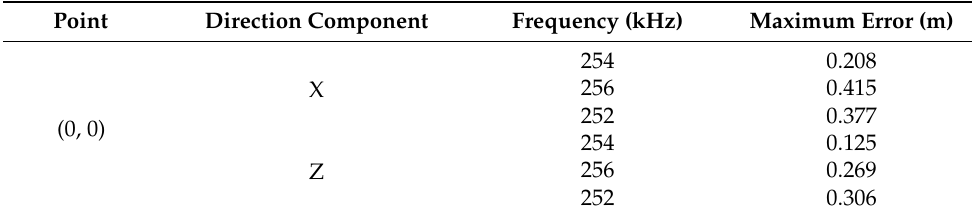
Table 1. Influence of different frequencies on positioning results.